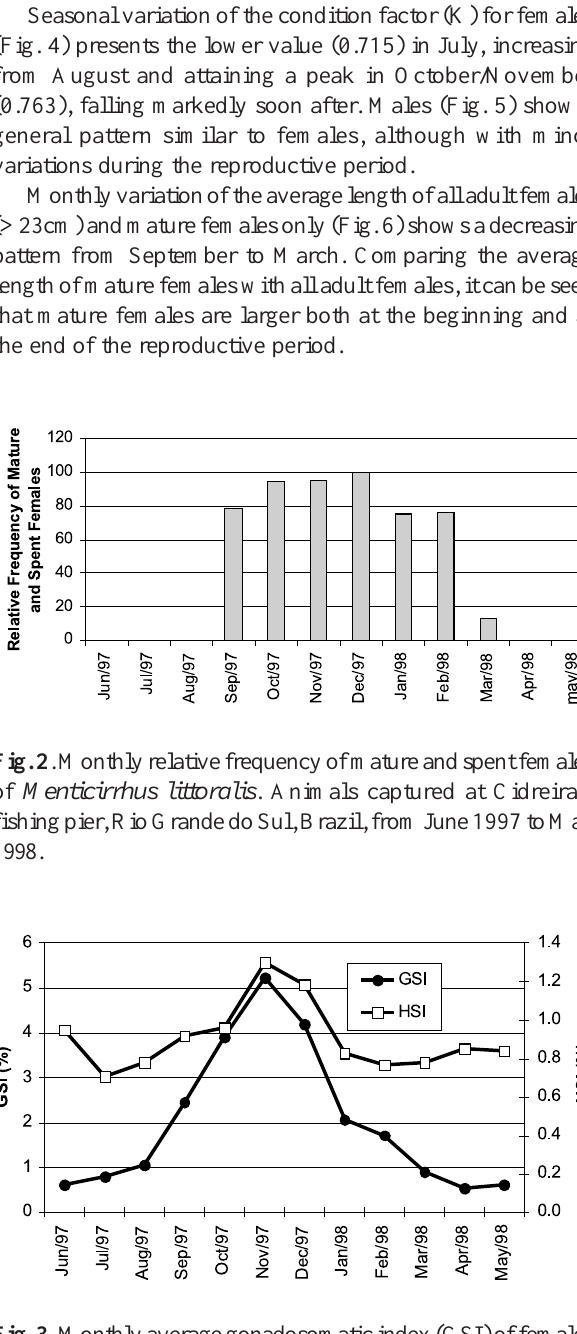
Fig. 6: Monthly average total length of adult females of Menticirrhus littoralis . Animals captured at Cidreira’s fishing pier, Rio Grande do Sul, Brazil, from June 1997 to May